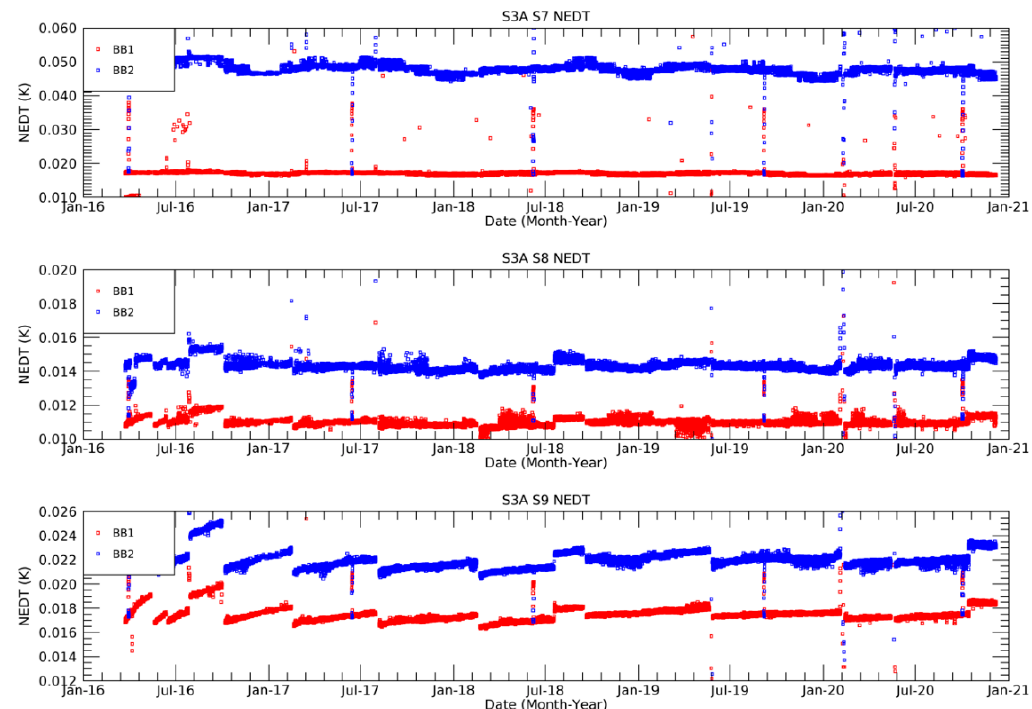
Figure 12. Sample images showing the output of the MapnoiS3 tool for SLSTR-B 12 µm BT images for a virtually cloud free North Sea on 22 April 2020 ( a – c ), and off the east coast of Australia during the extreme wildfire event on 1 January 2020 ( d – f ). The top row ( a , d ) shows the measured brightness temperatures, the centre images ( b , e ) show the fully random noise estimates and the bottom row ( c , f ) show the uncertainty due to correlated (systematic) effects.